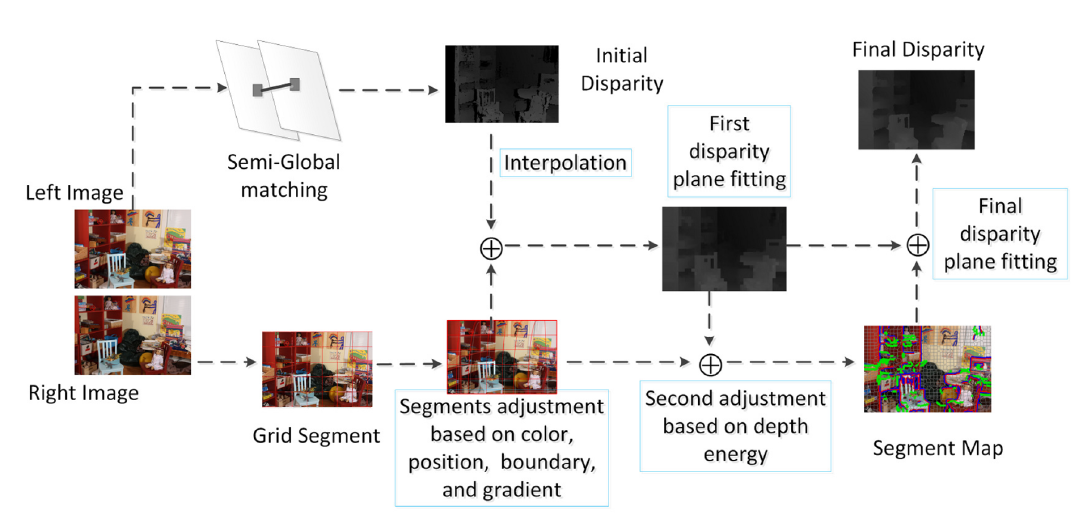
Figure 1. The flow chart of the proposed stereo matching